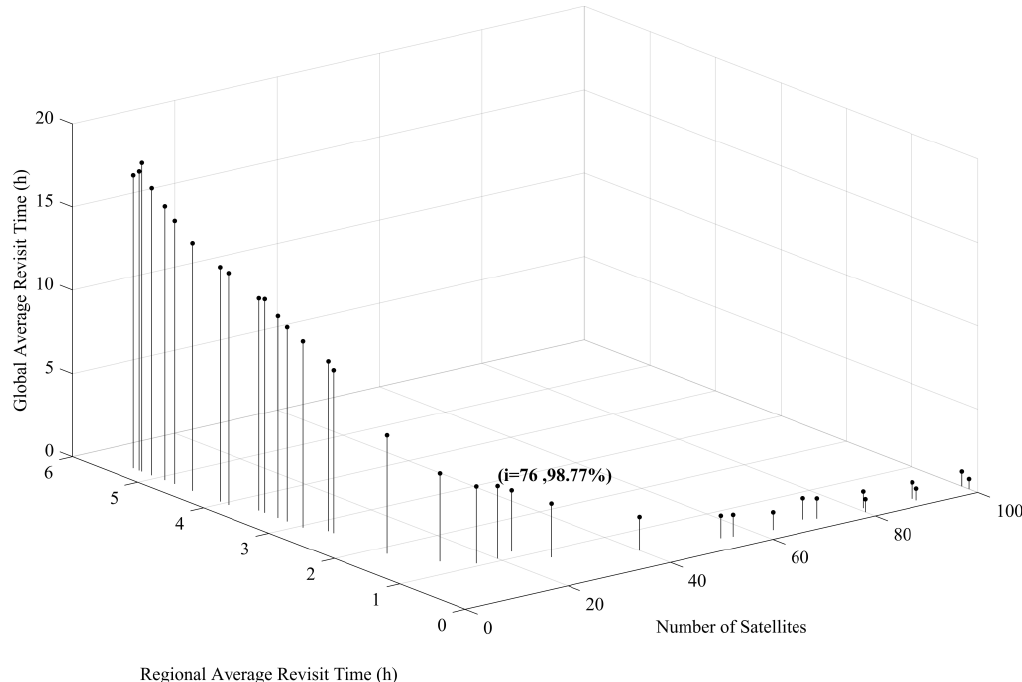
Figure 8. Relationship between the number of satellites, Regional ART, and Global ART in the optimal solution.